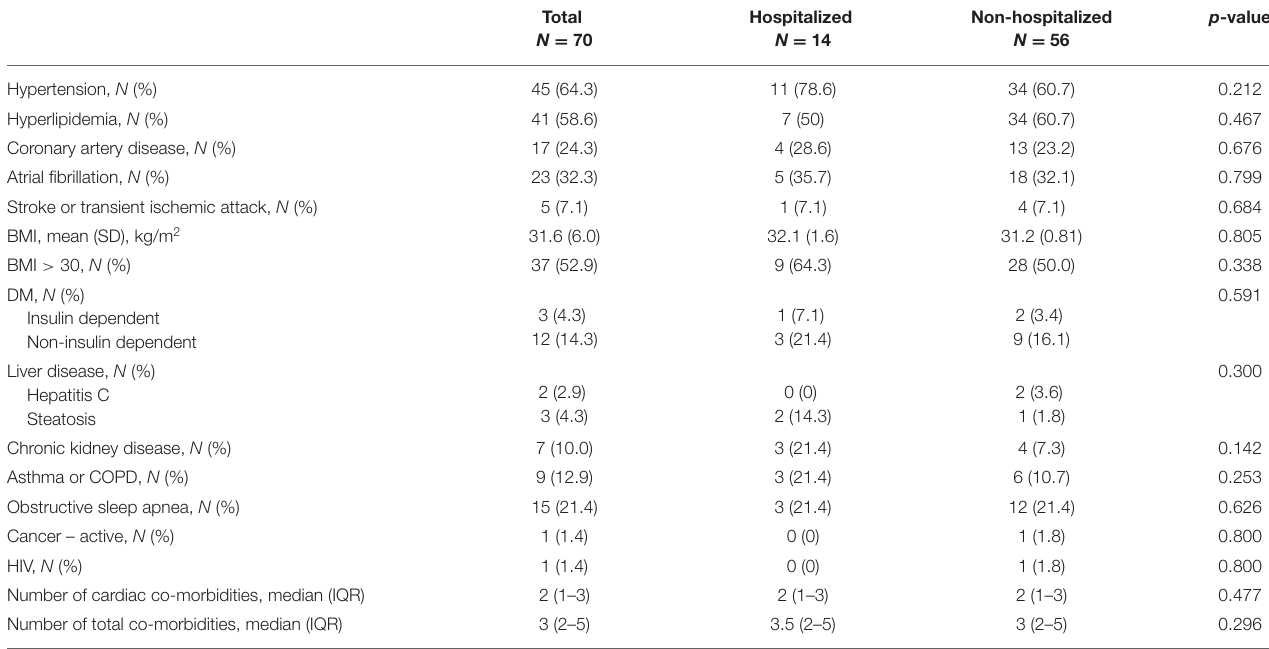
TABLE 2 | Co-morbidities.